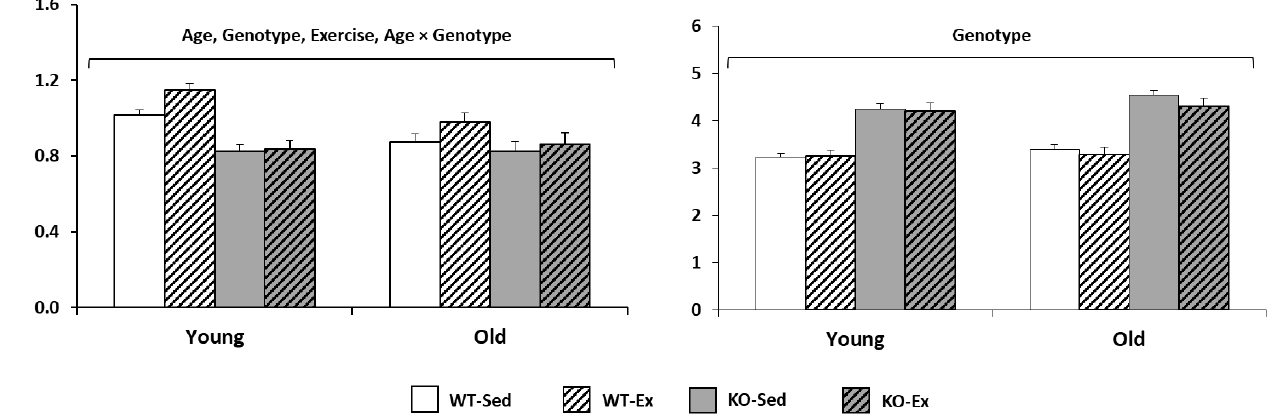
Figure 2. Glucose transporter type 4 (GLUT4) expression and glycogen content in the muscle. ( A ) Ageing and Sparc KO decreased muscular expression of GLUT4, but exercise increased it. The interaction (age × genotype) revealed that the effect of ageing was only seen in WT mice. ( B ) Sparc KO increased the muscular glycogen. All data are mean ± SEM. The number of mice: 11–12 mice per experimental condition. Abbreviations: Ex, exercise; KO, knockout; Sed, sedentary; Sparc , secreted protein acidic and rich in cysteine; WT, wild-type.